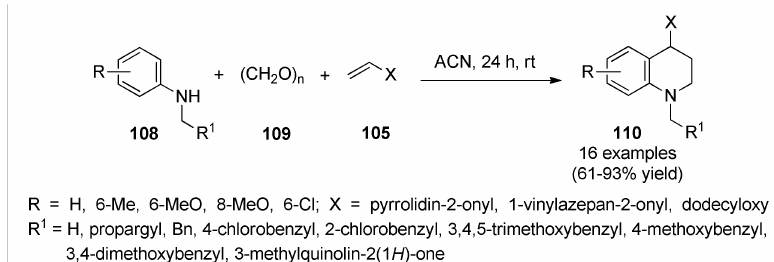
Scheme 46. Three-component Domino-Mannich / Friedel-Crafts alkylation reaction for the synthesis of 1,2,3,4-tetrahydroquinolines 110 of anticancer